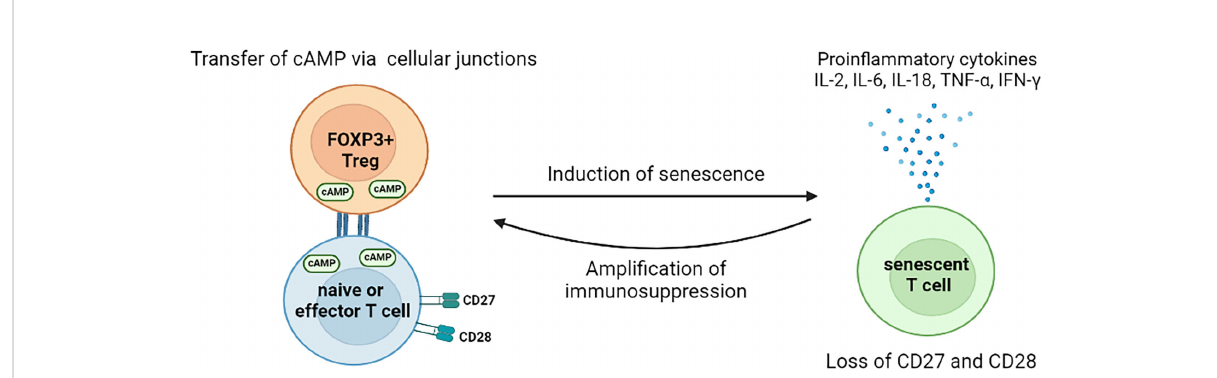
FIGURE 3 Mechanisms for FOXP3+ Treg cells to induce T cell senescence in the tumour microenvironment. The direct transfer of cAMPs, by Treg cells via cell junctions, induces the senescence of naïve and effector T cells. The induced senescent T cells cease the expression of CD27 and CD28 but increase the secretion of pro-in fl ammatory cytokines. Thus, those senescent T cells exhibit immunosuppressive features and argument the immunosuppression within TME. So far, no study of direct effect of tumour-associated Treg cells on tumour cell senescence has been found. However, Treg cells might mediate the senescence of tumour cells indirectly. For instance, the Treg cells induced senescent T cells exhibit unique SASP, which is characterized by augmented release of cytokines, chemokines, proteases, and metabolic wastes. The accumulation of these molecules as well as low glucose availability, caused by hyper-glycolysis of Treg cells, create a stress environment, thus may facilitate thesenescence of tumour cells. cAMP, cyclic adenosine monophosphate; IL, interleukin; TNF, tumour necrosis factor; IFN, interferon; TME, tumour microenvironment; SASP, senescence-associated secretory